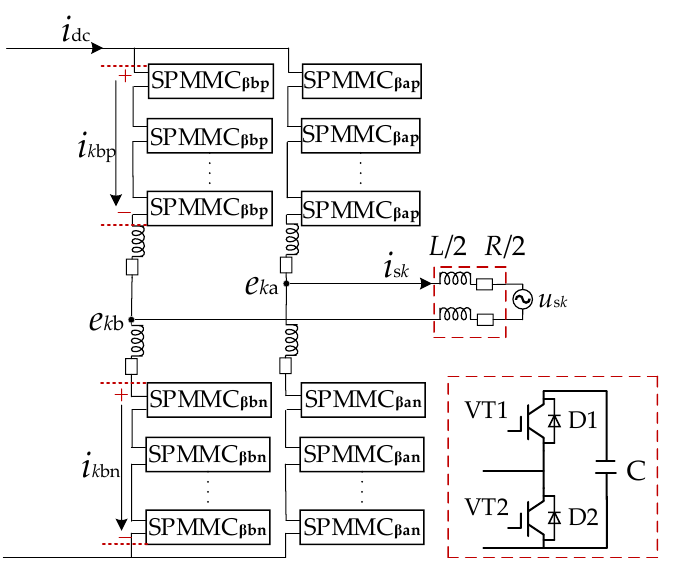
Figure 2. Topology of SP-MMC.